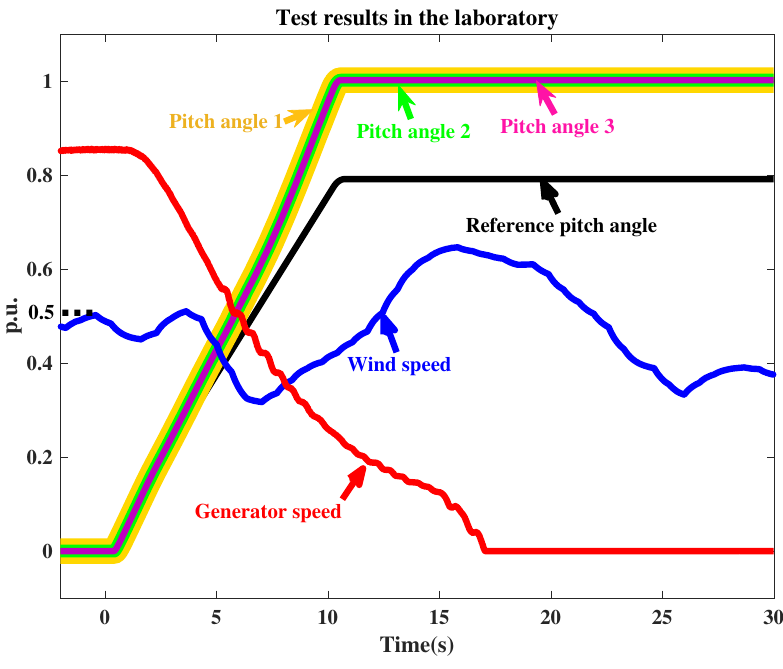
Figure 18. Test results in the laboratory. The p.u. values of the pitch angle, generator speed and wind speed are 91 ◦ , 1750 rpm and 11 m/s, respectively.